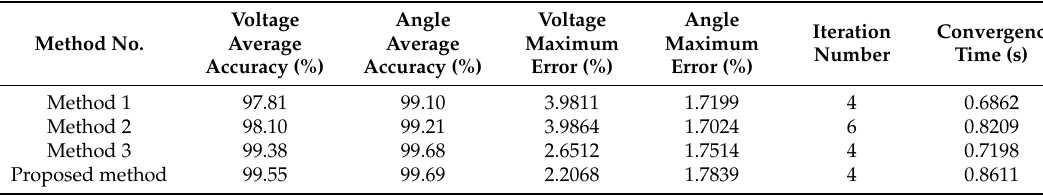
Table 6. The results of state estimation of four methods in 30 bus system.